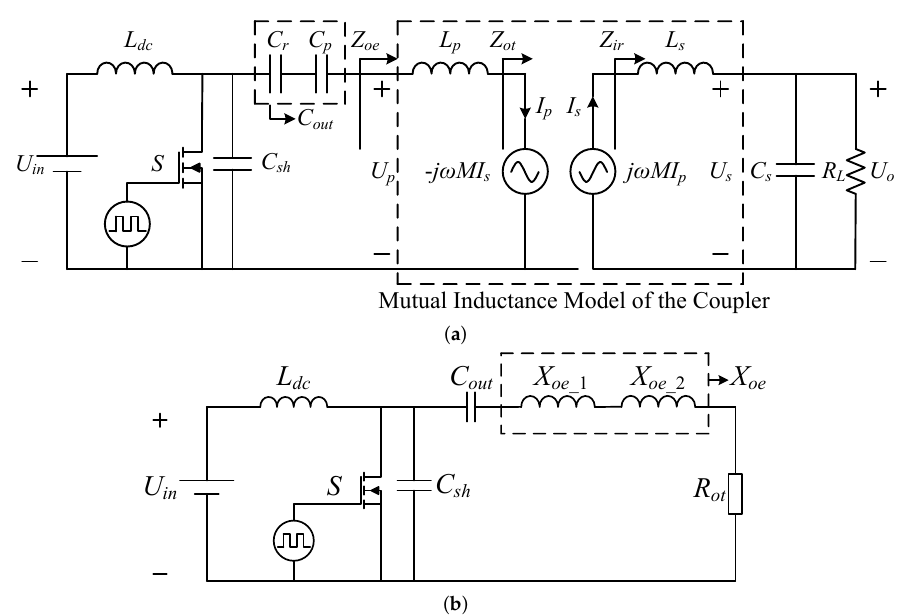
Figure 2. Equivalent circuit model of the electromagnetic coupling power transfer charger (ECPTC). ( a ) Simplified schematic circuit of the charger; ( b ) Schematic circuit reflected to the transmitter